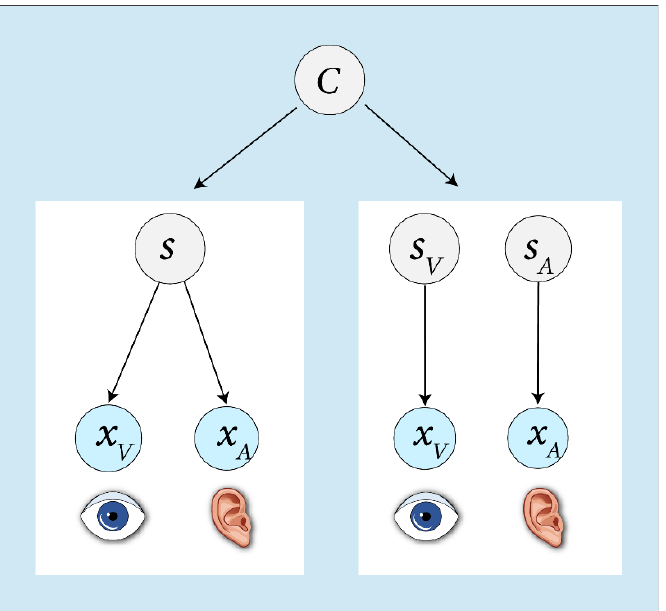
Figure 1. The generative model of Bayesian causal inference [5]. Two causal structures can give rise to auditory and visual stimuli x A and x V . Either a common cause ( s ) has produced the stimuli ( C = 1 ) , or independent causes s A and s V , have produced the two stimuli ( C = 2 )